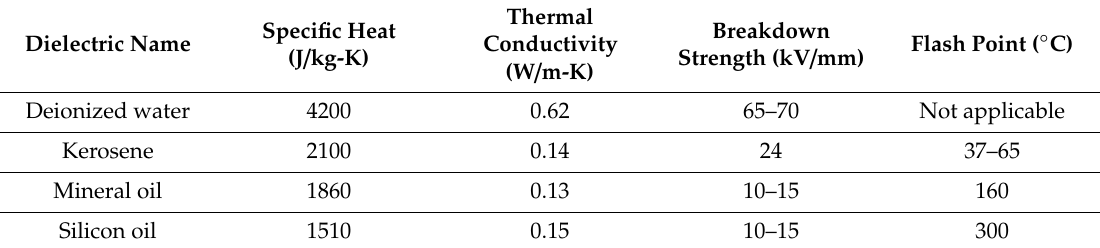
Table 5. Properties of typical dielectrics used in